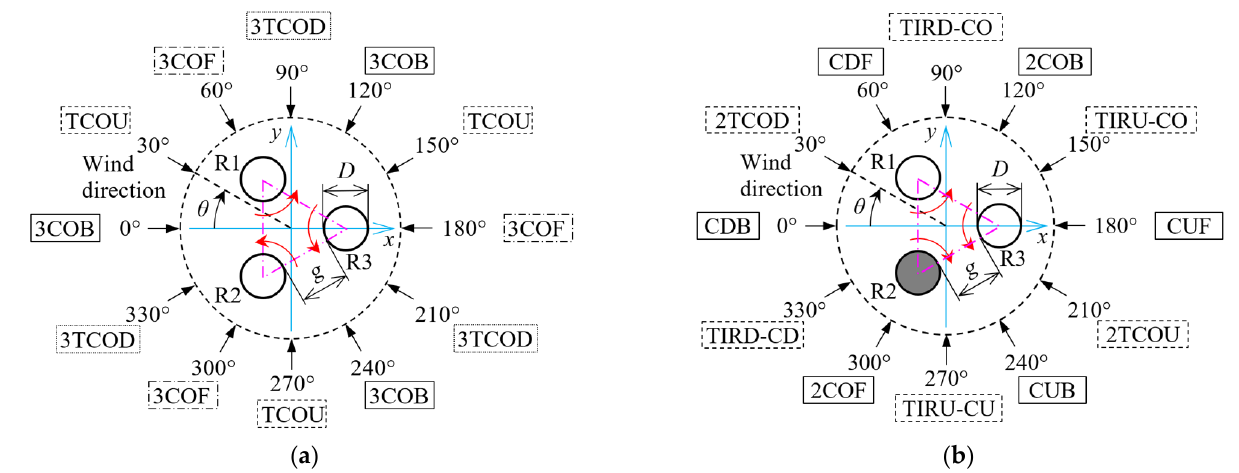
Figure 4. Definition of 12 ‐ wind ‐ direction configurations in a closely spaced VAWT trio: ( a ) co ‐ rotation trio (3CO); ( b ) inverse ‐ rotation trio (3IR).